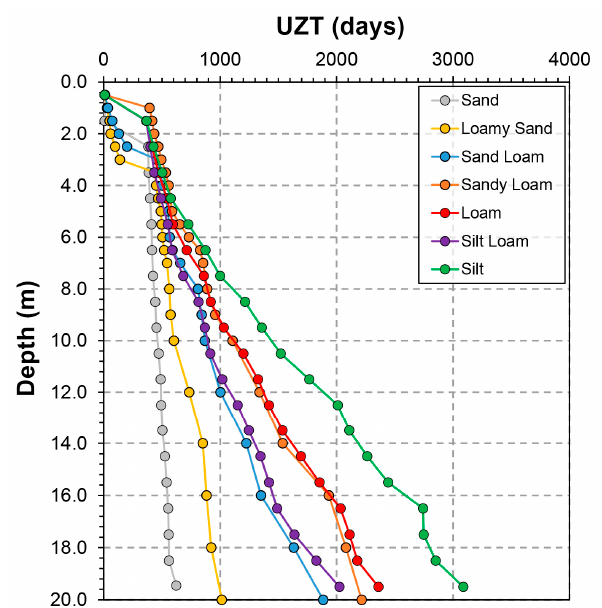
Figure 6. Variation of the Unsaturated Zone travel Time (UZT) with depth and textural classes obtained from homogeneous hydro-stratigraphic models.